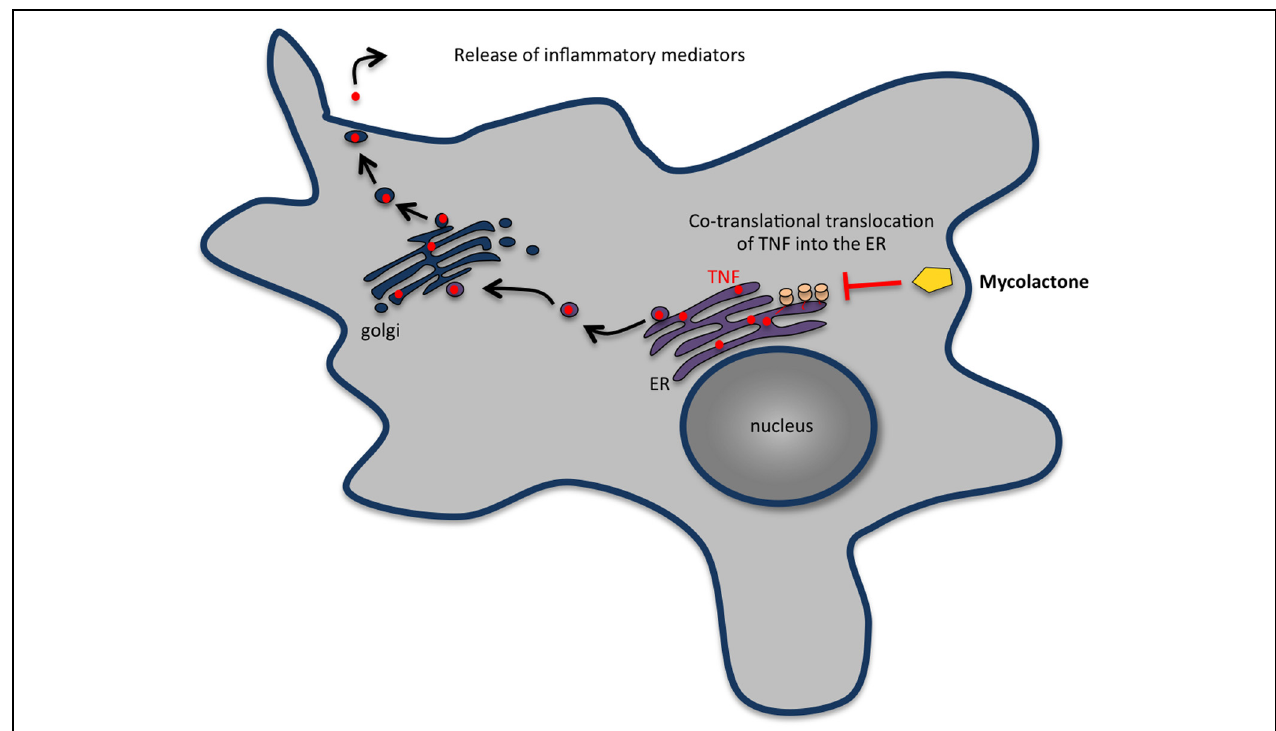
FIGURE 5 | Mycolactone inhibits the secretion of most cytokines, chemokines and other inflammatory mediators by macrophages. In eukaryotic cells, secretory proteins cross the ER membrane before being transported in vesicles to the Golgi complex and then to the plasma membrane. Mycolactone enters cells by passive diffusion through the plasma membrane and inhibits the production of inflammatory mediators by macrophages by blocking the translocation of nascent proteins into the ER. The proteins wrongly accumulated in the cytosol are then degraded by the